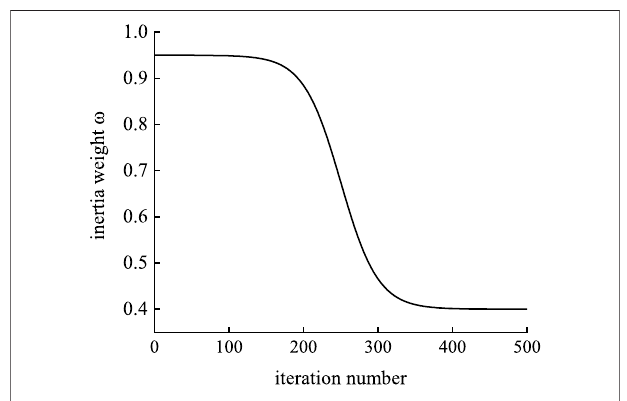
FIGURE 7 | Diagram of adaptive variation of inertia